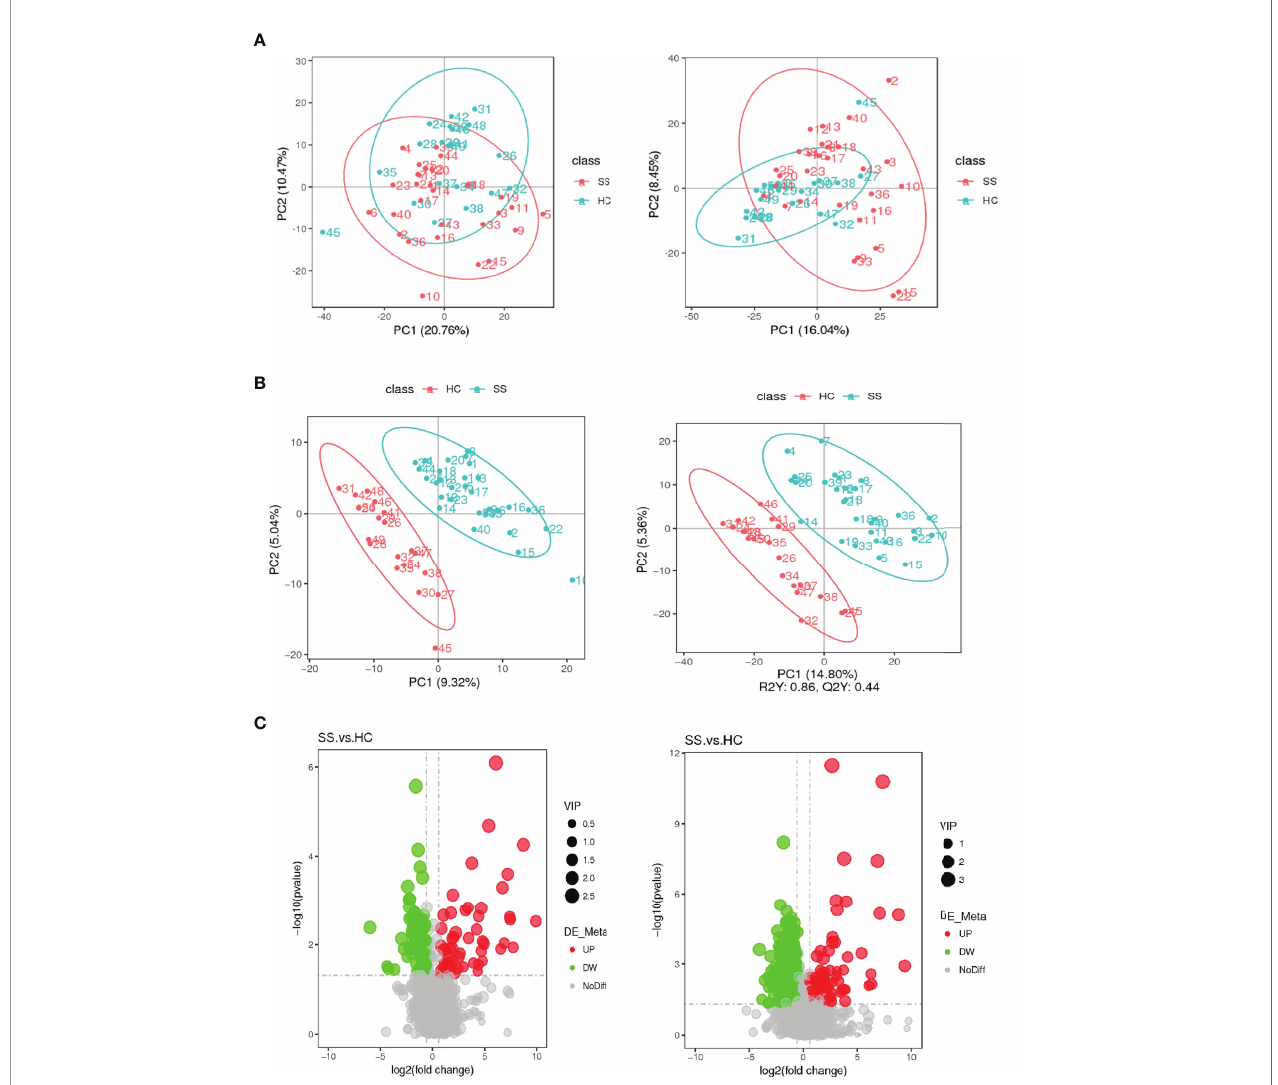
FIGURE 4 | Score plots of the PCA and PLS-DA models and volcanic map of differential metabolites. (A) Score plot of the PCA model in the ESI- and ESI+ ion modes. (B) Score plot of the PLS-DA model in the ESI- and ESI+ ion modes. (C) Volcanic map of differential metabolites. The horizontal coordinate represents the fold change (log2FoldChange) of metabolites in different groups, and the vertical coordinate represents the signi fi cance level of the difference (-log10P value). Each point in the volcano map represents a metabolite, in which the metabolites with signi fi cantly up-regulated expression are represented by red dots, and those with signi fi cantly down-regulated expression are represented by green dots. The dot size VIP values are represented by dot